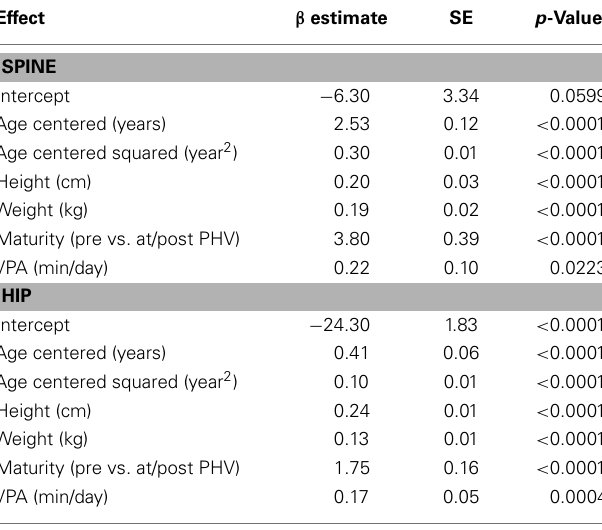
Table 5 | Fixed-effects of the multi-level models examining the association ofVPA with spine and hip BMC in females